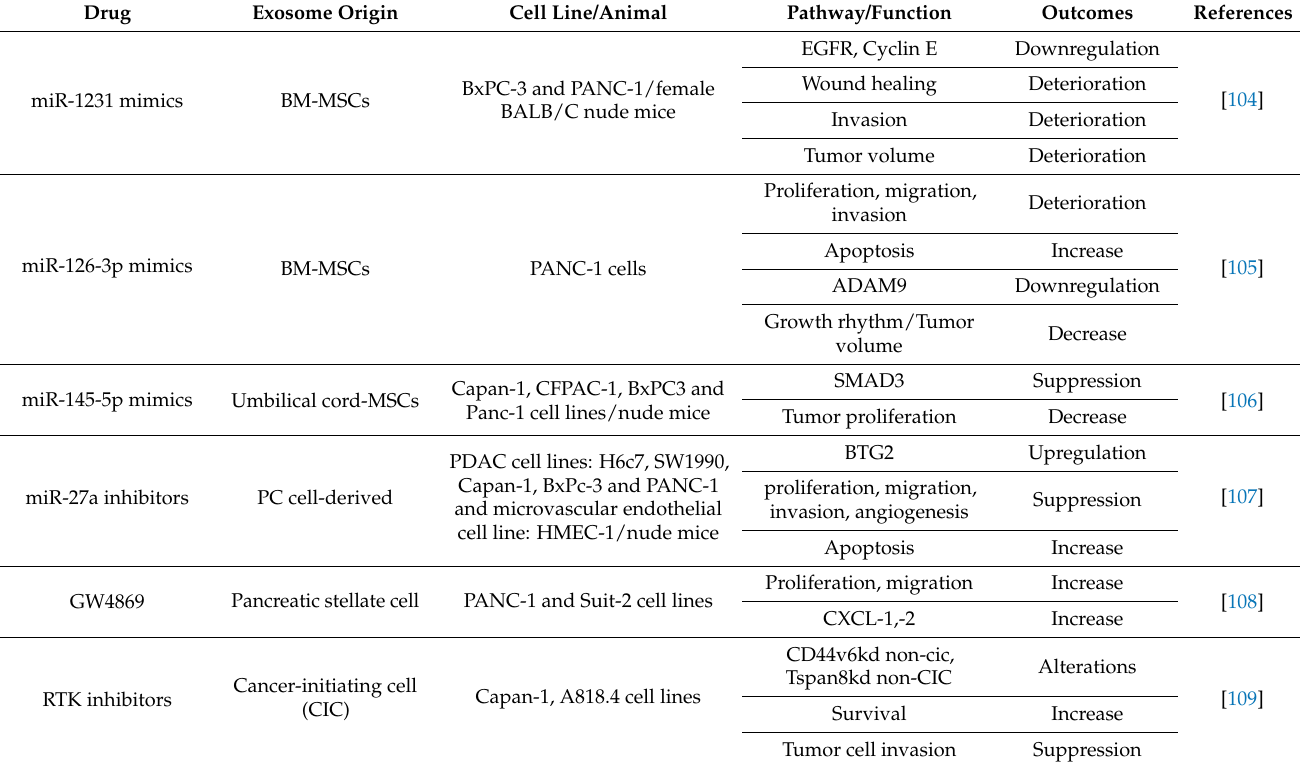
Table 2. The preclinical data regarding the impact of certain exosomal miRNAs in